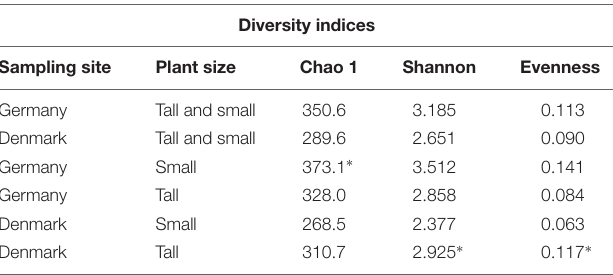
TABLE 2 | Alpha diversity indices calculated from 18S rRNA sequence data at the OTU level of the fungal of A. nordmanniana collected in Germany and